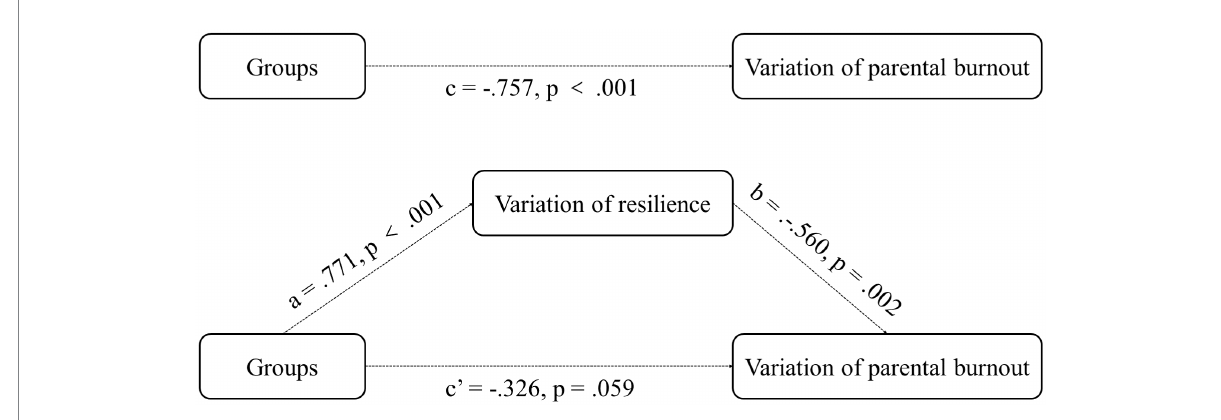
FIGURE 1 Simple mediation model evaluation the effect of the variation of resilience as a mediator between intervention and the variation of parental burnout, data is expressed by value analyzed by a linear regression